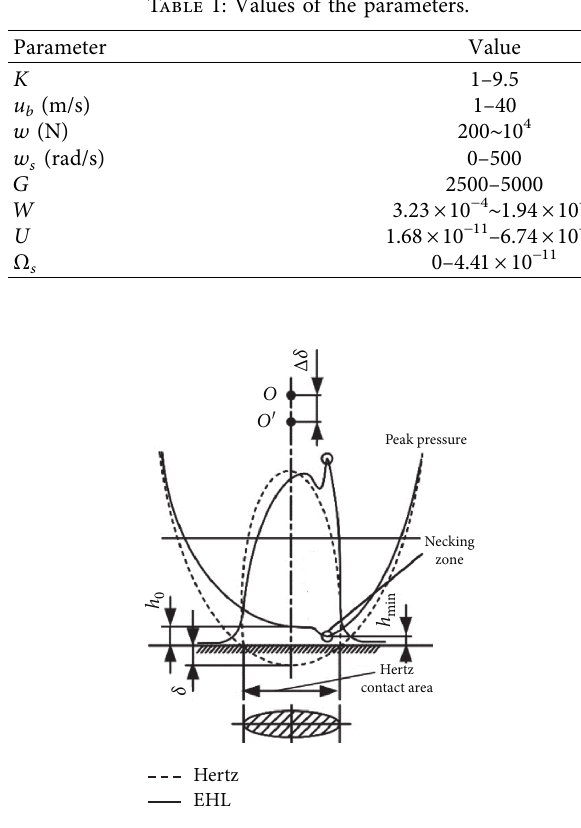
Figure 3: Lubricant film thickness and pressure distribution under EHL and Hertz contact